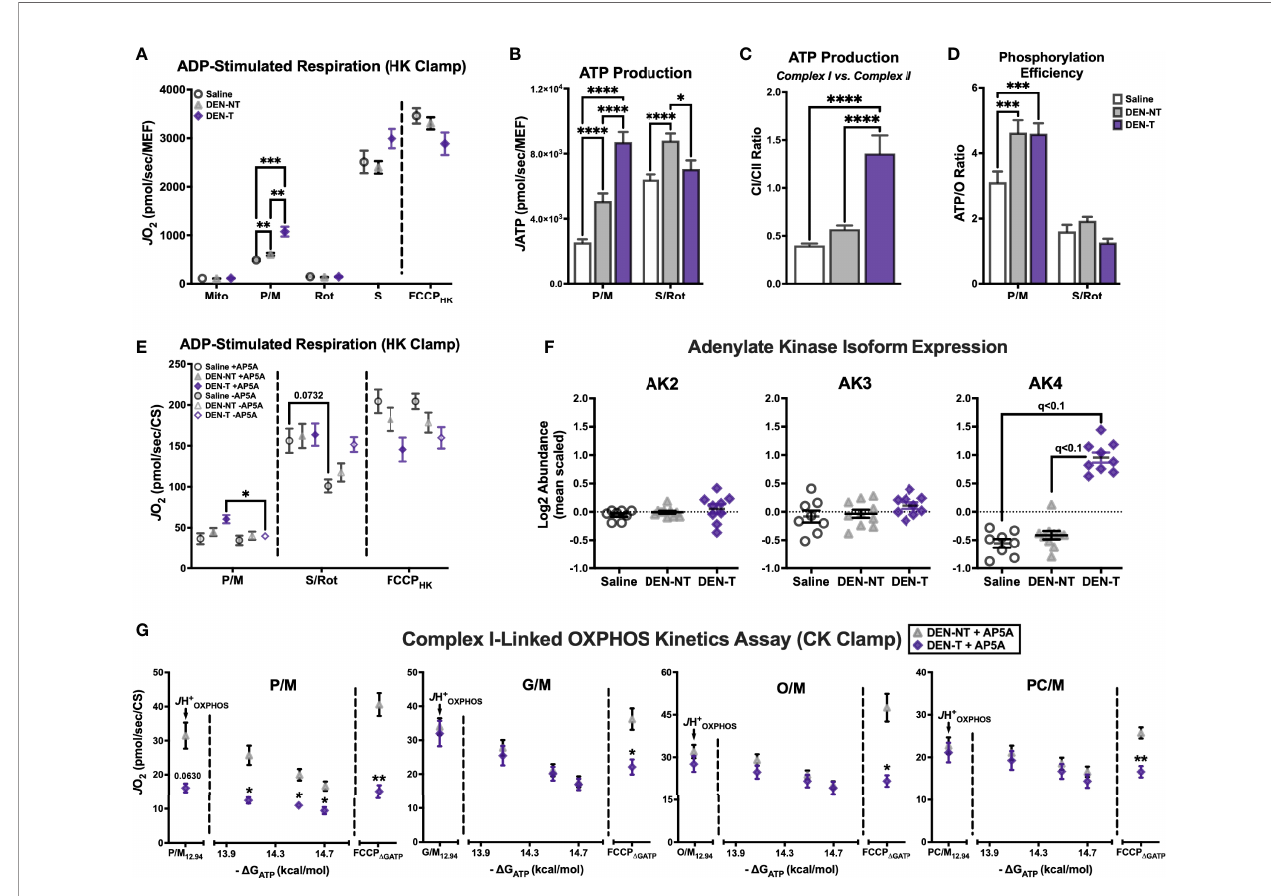
FIGURE 5 | Upregulation of adenylate kinase 4 (AK4) in DEN-induced tumor mitochondria contributes to altered complex I-linked respiratory fl ux. (A) ADP- stimulated protocol fueled by P/M and S/Rot. (B) Comparison of J ATP fueled by P/M and S/Rot. (C) Ratio of CI-supported (P/M) J ATP to CII-supported (S/Rot) J ATP from (B) . (D) Comparison of ATP/O ratios fueled by P/M and S/Rot. (E) ADP-stimulated protocol fueled by P/M and S/Rot in the presence (+) and absence (-) of adenylate kinase (AK) inhibitor Ap5A; data normalized to CS activity. (F) Relative expression of AK isoforms 2-4. (G) OXPHOS kinetics protocols in the presence of Ap5A fueled by P/M, G/M, O/M, PC/M; data normalized to CS activity. Data are presented as mean ± SEM and analyzed by two-way ANOVA (A, B, D, E, G) and one-way ANOVA (C) . *p < 0.05, **p < 0.01, ***p < 0.001, ****p <